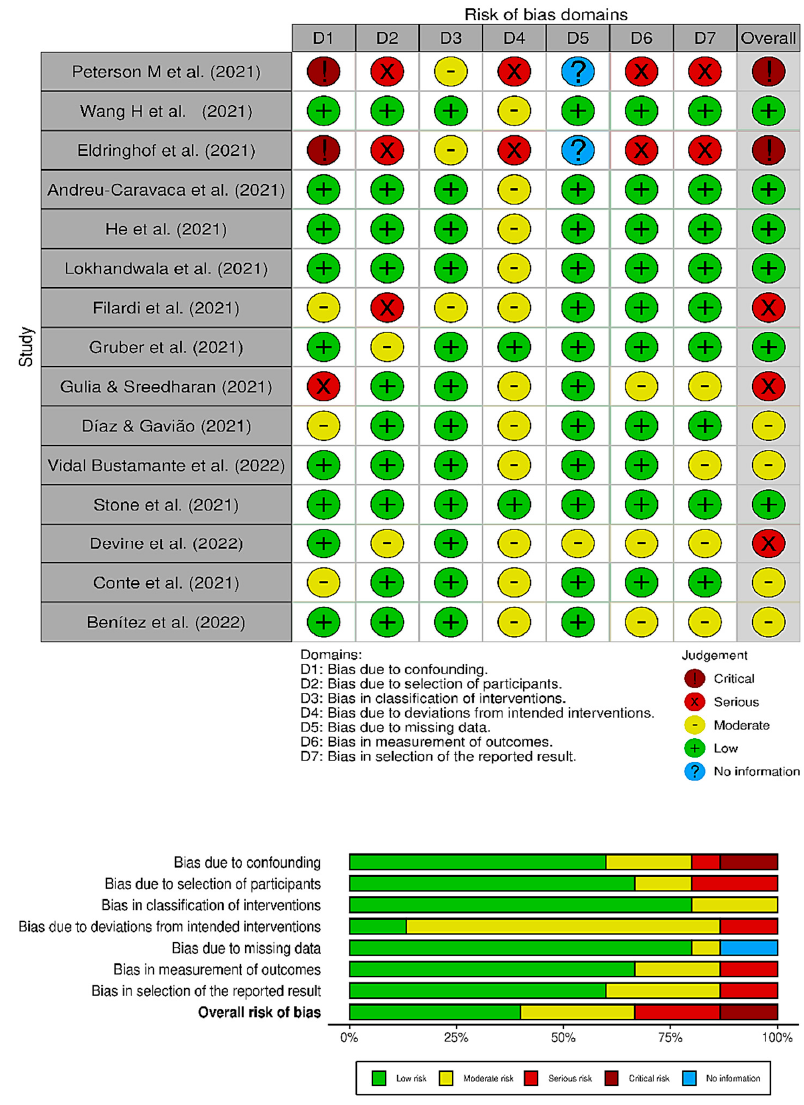
Figure 3. ACROBAT-NRSI risk of bias of the selected publications